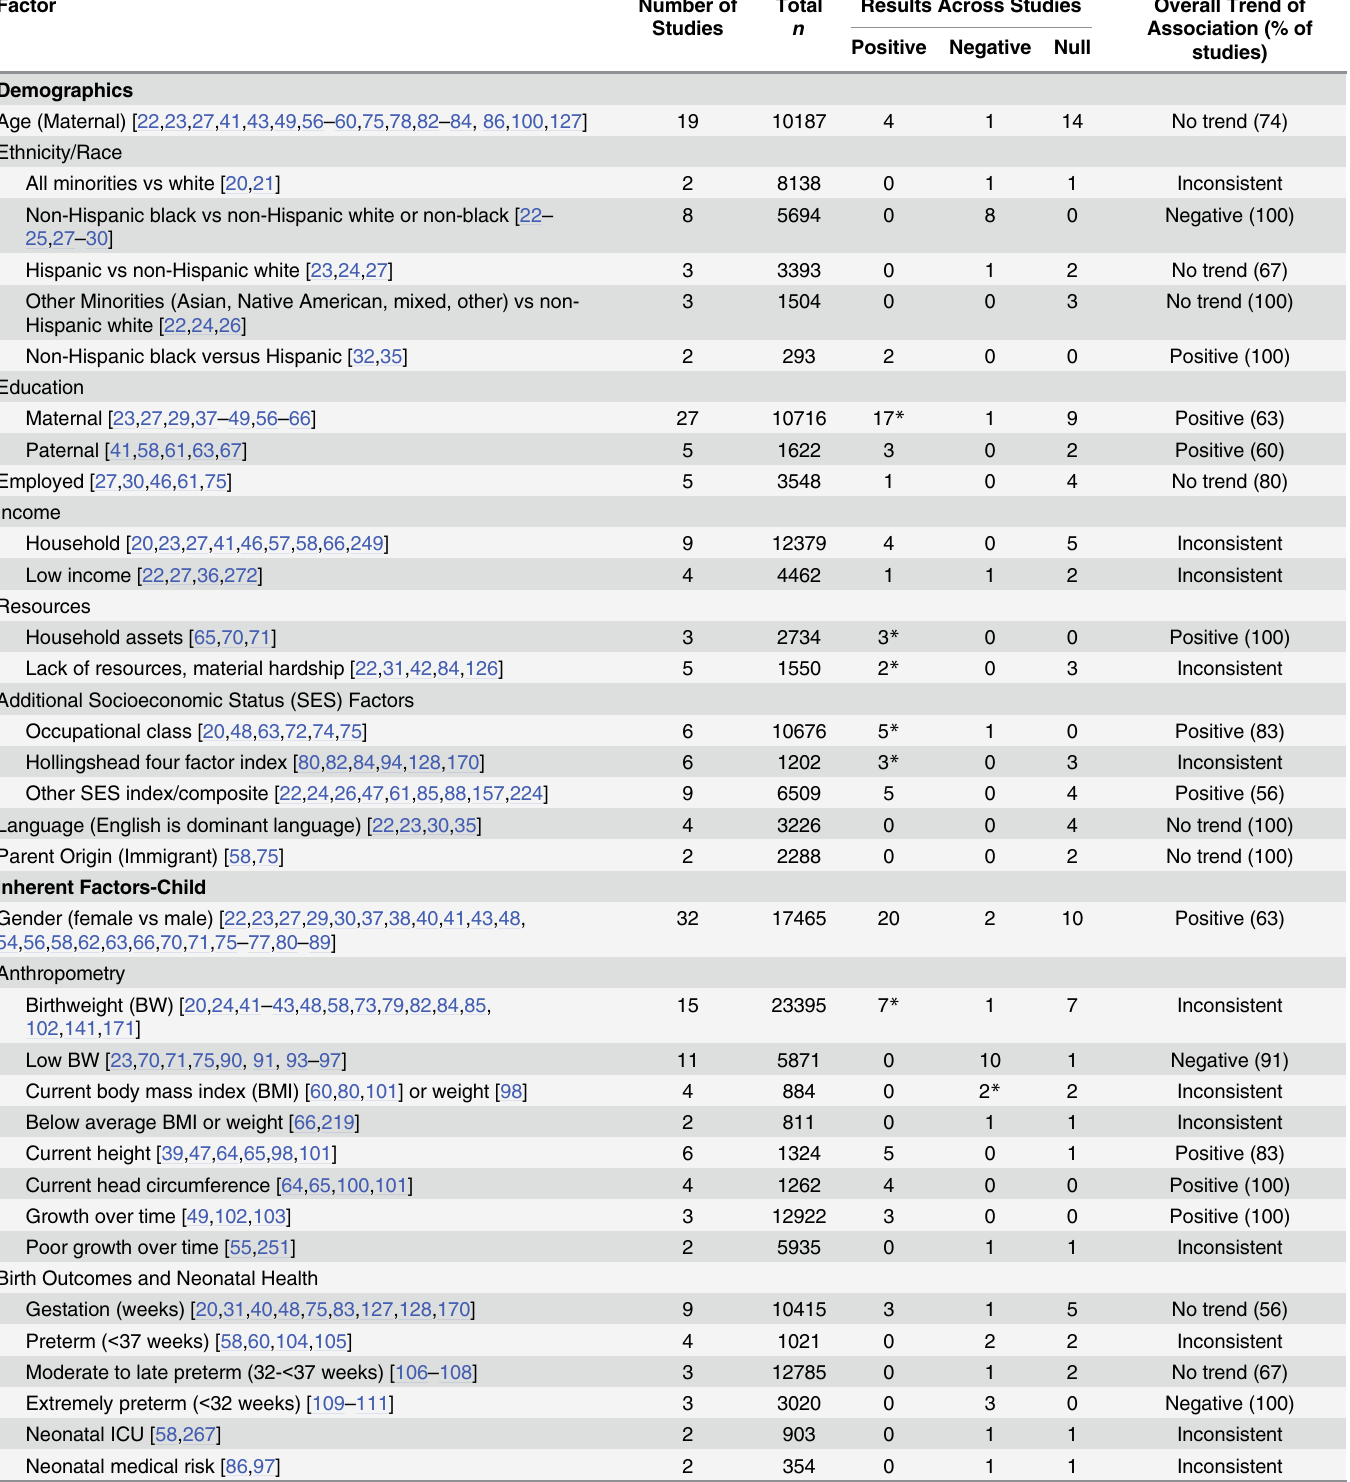
Table 2. Factors Examined in Multiple Studies as EOI or IP of General Cognitive